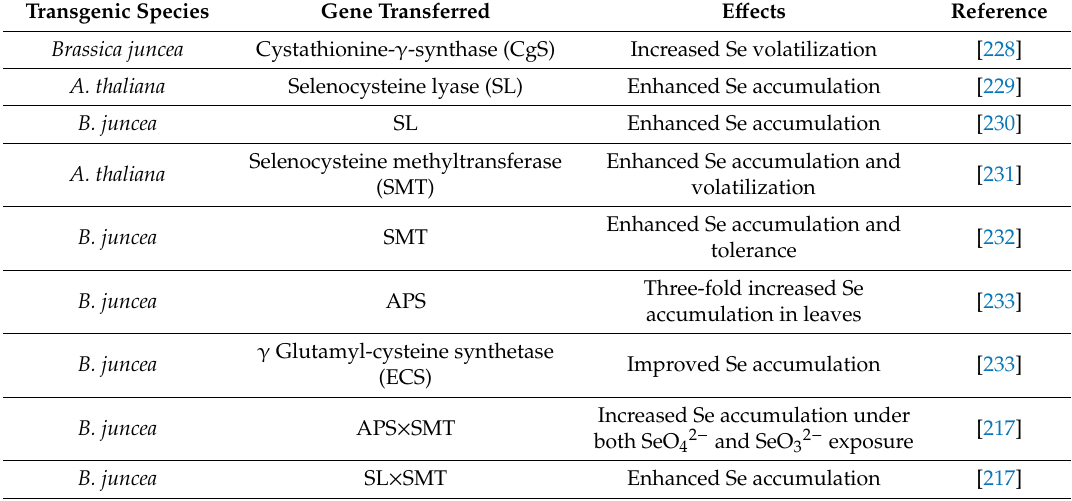
Table 4. Transgenic plants and the candidate genes for the targeted